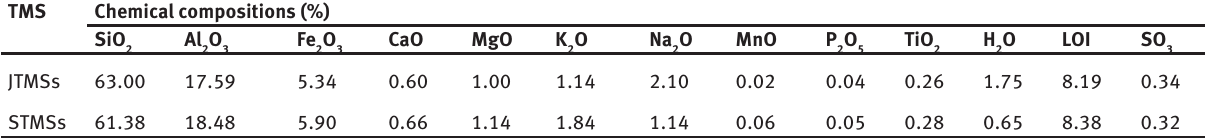
Table 1: Oxide compositions of TMS. TMS Chemical compositions (%)